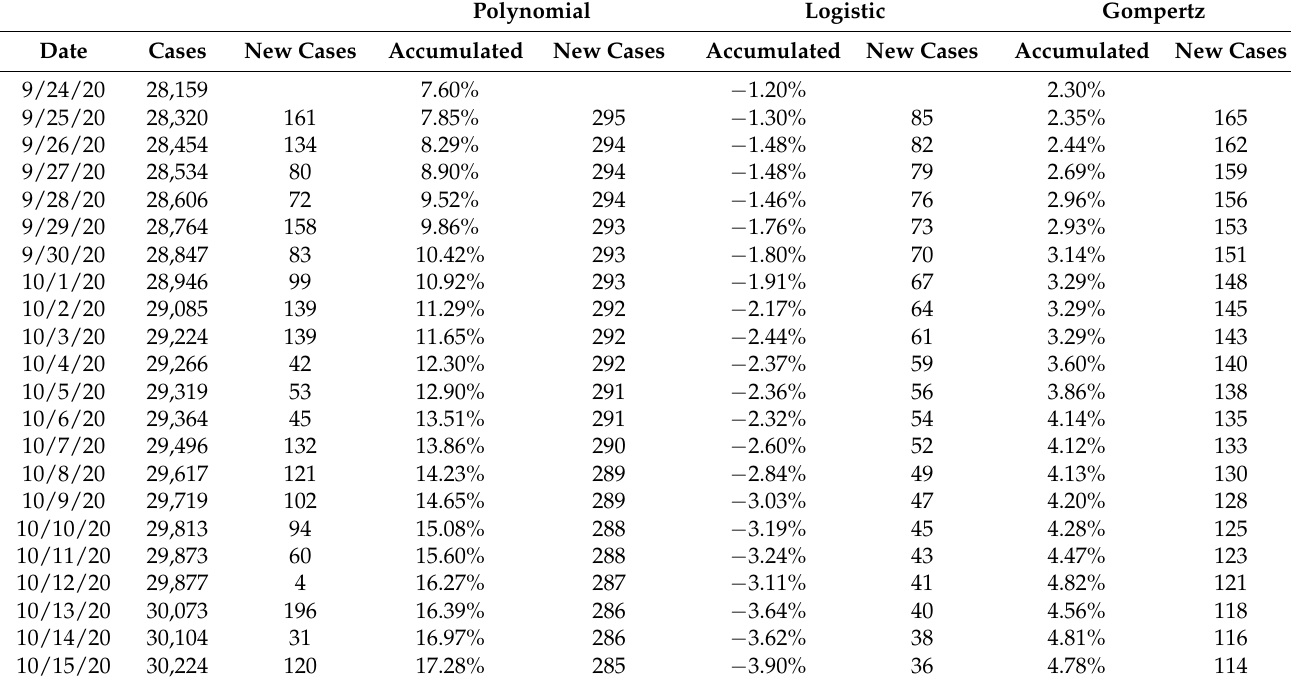
Table 8. Daily new COVID-19 cases predicted from total cumulative cases in the state of Tamaulipas. Polynomial